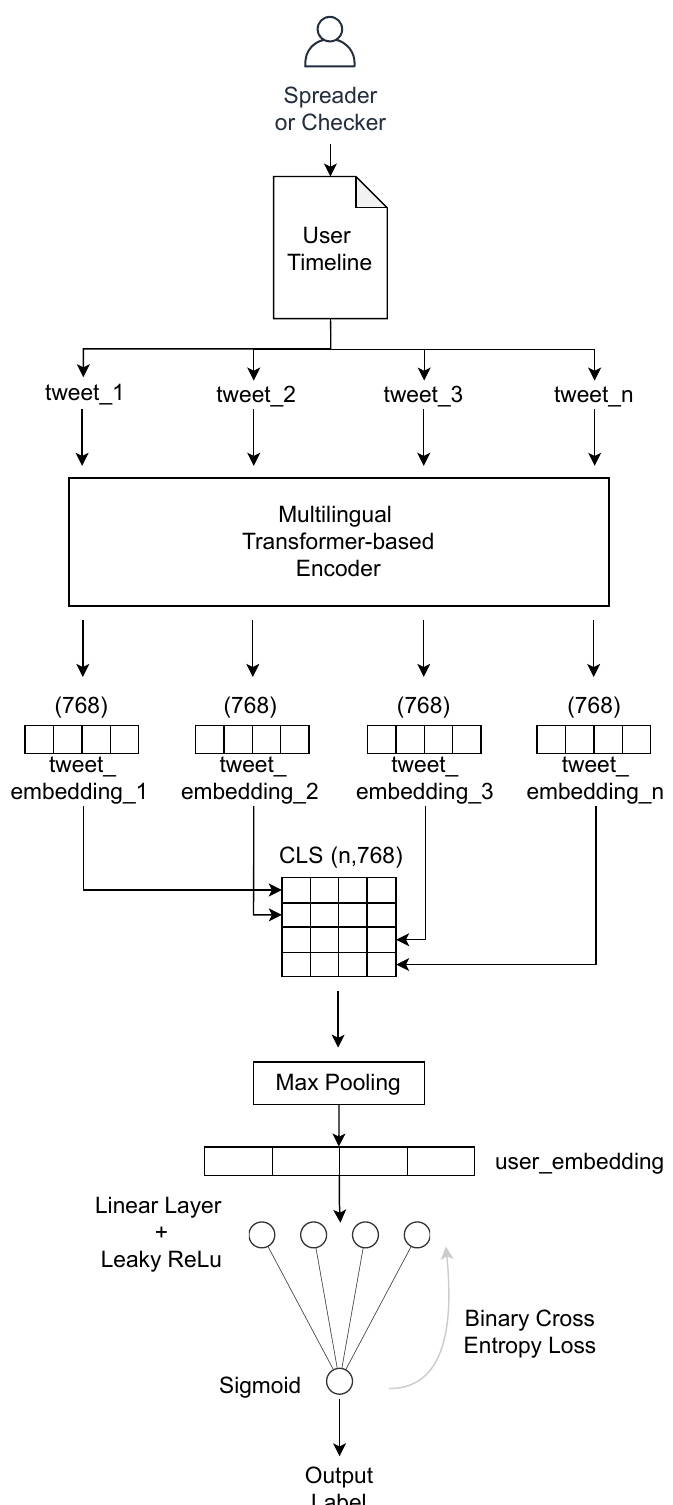
Figure 5. FNSC (Fake News Spreader Classifier) architecture